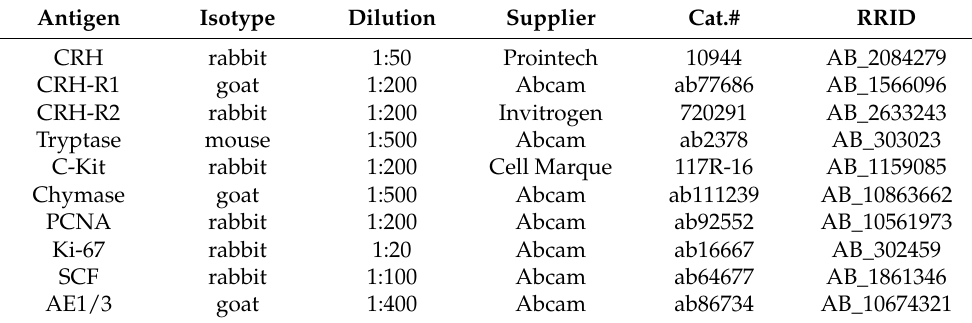
Table 1. List of primary